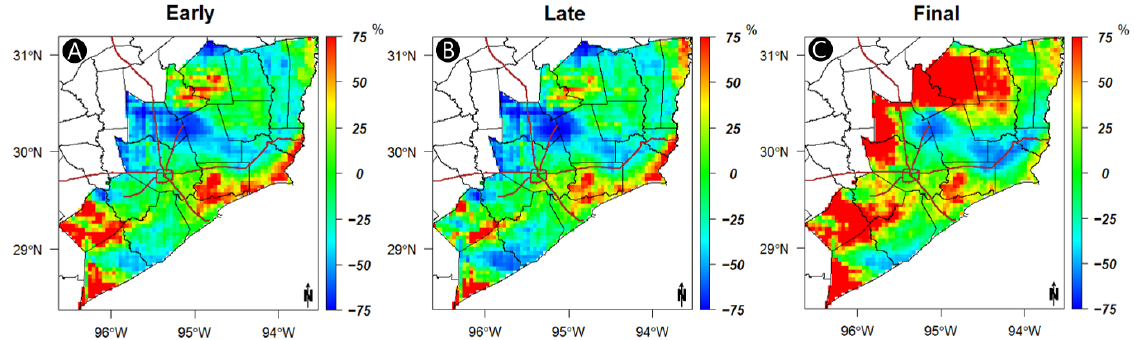
Figure 8. Spatial distribution of RBIAS for the IMERG ( A ) Early-, ( B ) Late-, and ( C ) Final-run products during Tropical Storm Imelda.